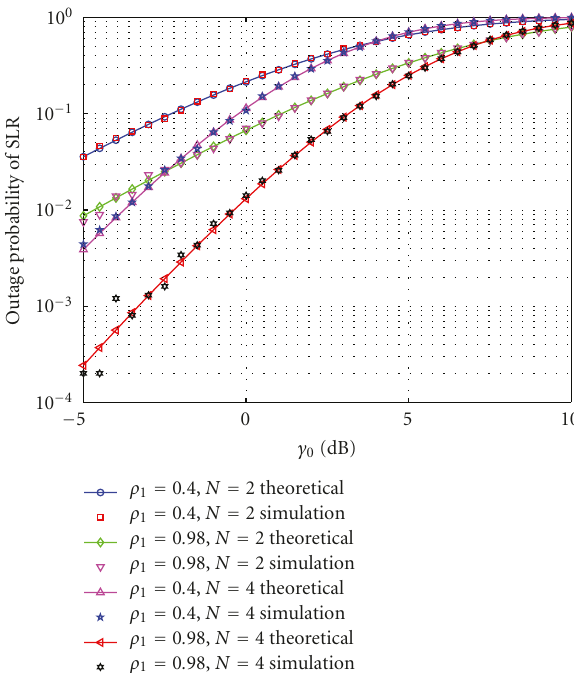
Figure 4: Comparison of theoretical and simulated outage proba- bility as a function of γ 0 for the user i = 1 (exponential correlation